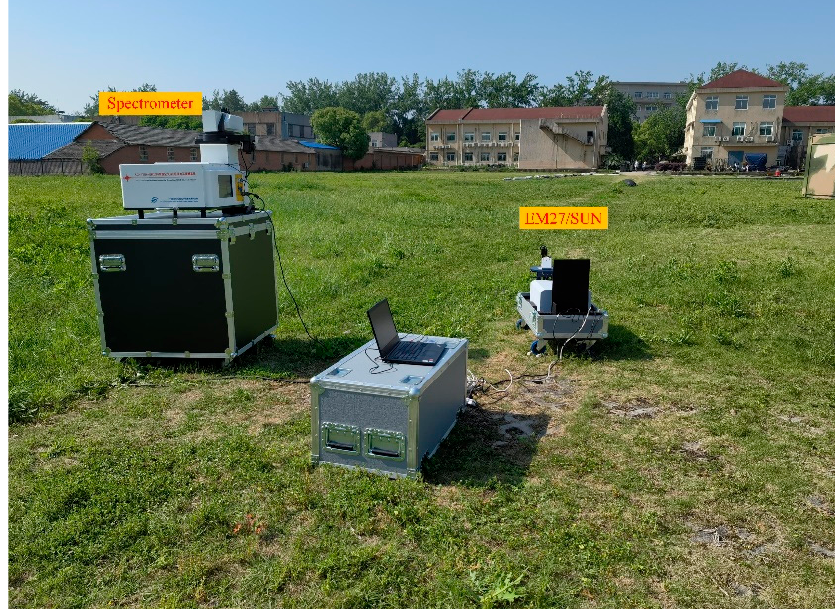
Figure 28. Synchronous observation of HRFTS and EM27/SUN. Through synchronous measurement, the interference free and high-quality spectral data were screened and time matched with the EM27/SUN data. Then, the inversion algorithm was used to retrieve the CO 2 and CH4 concentrations. Through comparison, it was found that the average deviations between the CO 2 and CH 4 concentrations retrieved from the spectrometer observation data and the inversion results of EM27/SUN were 0.83 ppm and 10.15 ppb (as shown in Figure 29), and the results of the two observation devices were consistent.